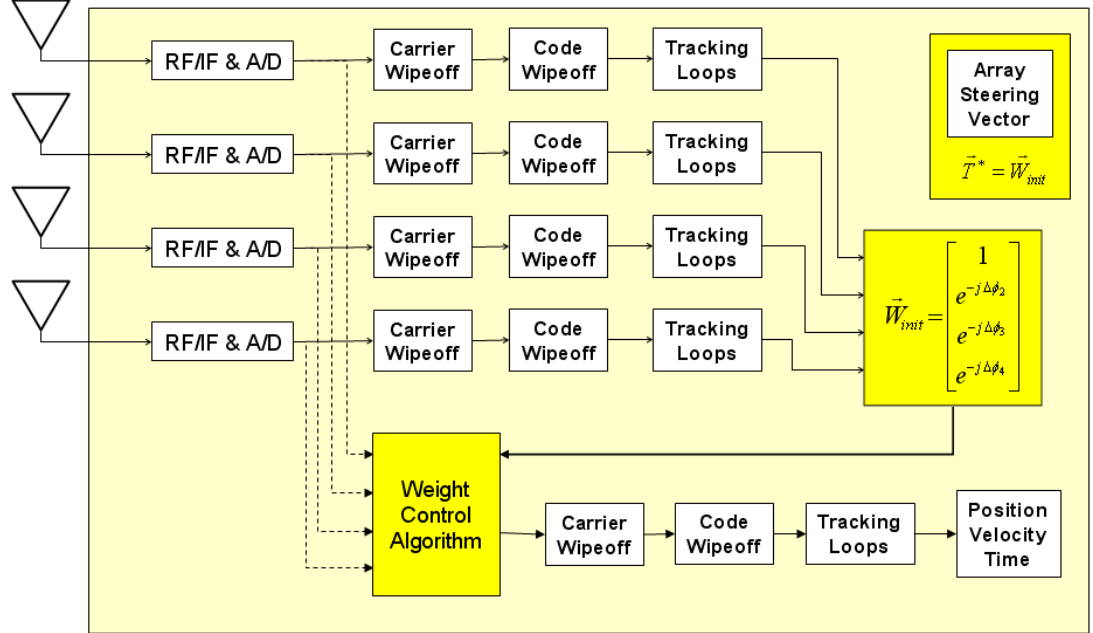
Figure 2. Inter-channel phase alignments using independent satellite tracking channels for each antenna element. Different array steering vectors are obtained at each epoch for different satellites ( i.e. , 12 different steering vectors for our GPS SDR supporting 12 beamsteering